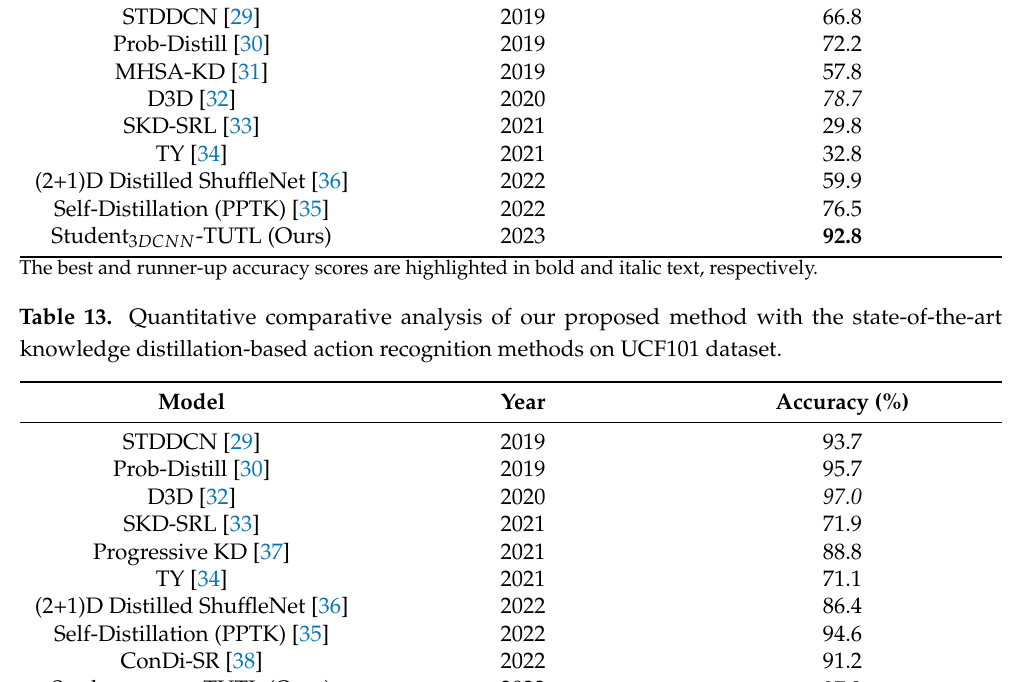
Table 12. Quantitative comparative analysis of our proposed method with the state-of-the-art knowledge distillation-based action recognition methods on HMDB51 dataset.